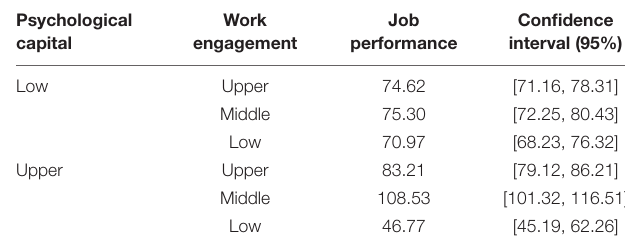
TABLE 3 | The moderating effect of psychological